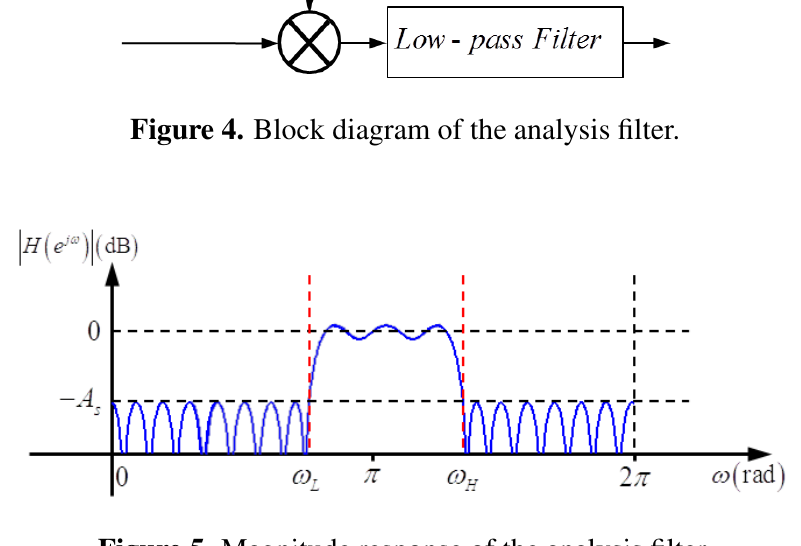
Figure 5. Magnitude response of the analysis